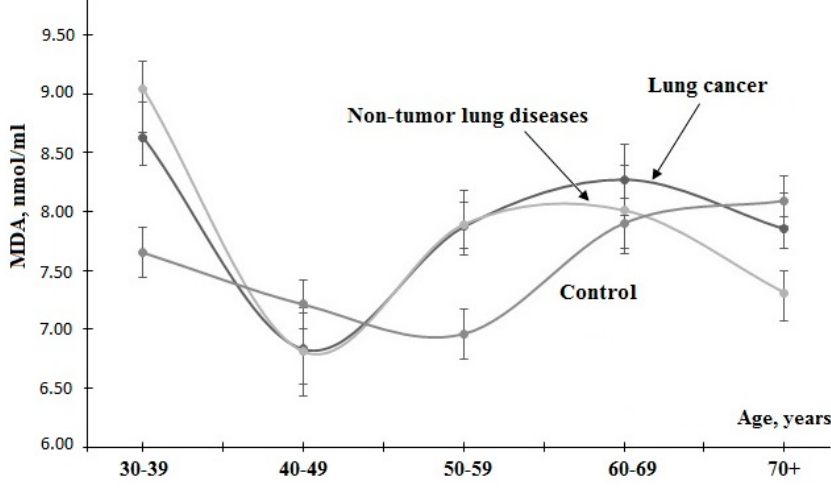
Figure 4. Dynamics of MDA levels depending on age.